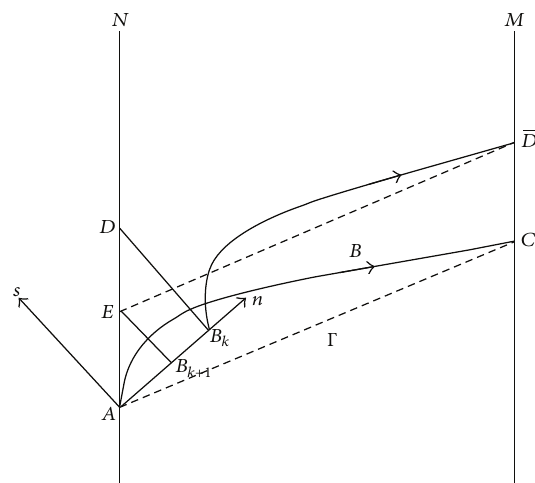
Figure 8: Establish coordinate system (𝑠,𝑛) on point 𝐴 . 𝑛 passing through 𝐴 ∈ Γ and establish coordinate system (𝑠, 𝑛) on point 𝐴 . Choose any point 𝐷 ∈ 𝑁 in small enough neighborhood of 𝐴 . The trajectory starting from 𝐷 intersects vertically 𝑛 -axis at 𝐵 𝑘 and intersects impulse set 𝑀 at 𝐷 . 𝐸 denotes the phase point of 𝐷 , the trajectory passing through point 𝐸 intersects vertically 𝑛 -axis at 𝐵 𝑘+ 1 as 𝑡 increases. Assume rectangular coordinate of 𝐴 is (𝜑(𝑠), 𝜓(𝑠)) ;